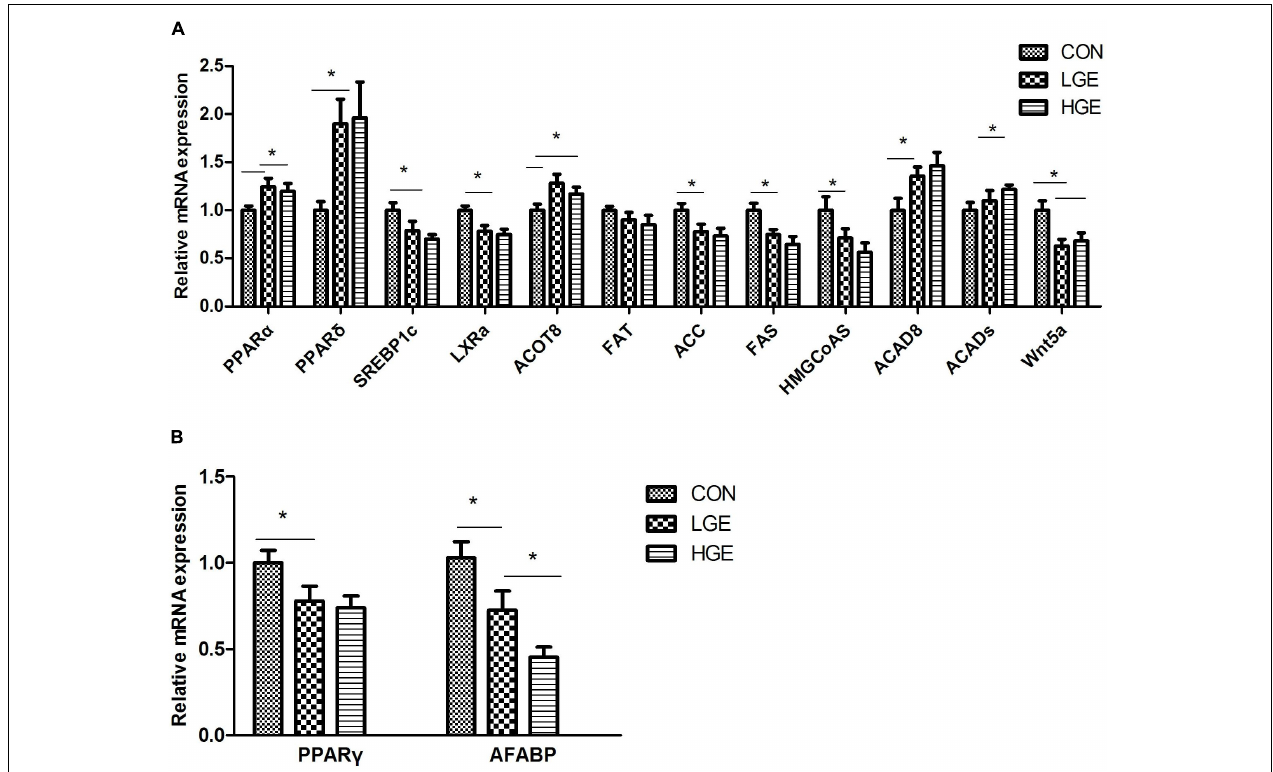
FIGURE 4 | (A,B) Represent the effect of GEN supplementation on the relative mRNA expression of genes related to lipid metabolism in the liver and abdominal fat, respectively; n = 8 replicates. Data represent the mean ± SEM of the values. Means with ∗ are significantly